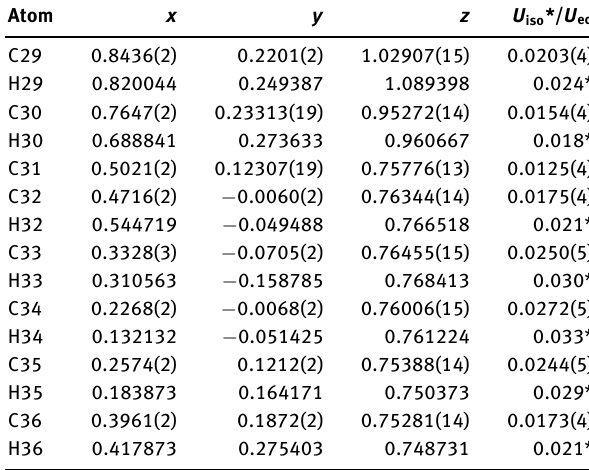
Table 2: Fractional atomic coordinates and isotropic or equivalent isotropic displacement parameters (Å 2